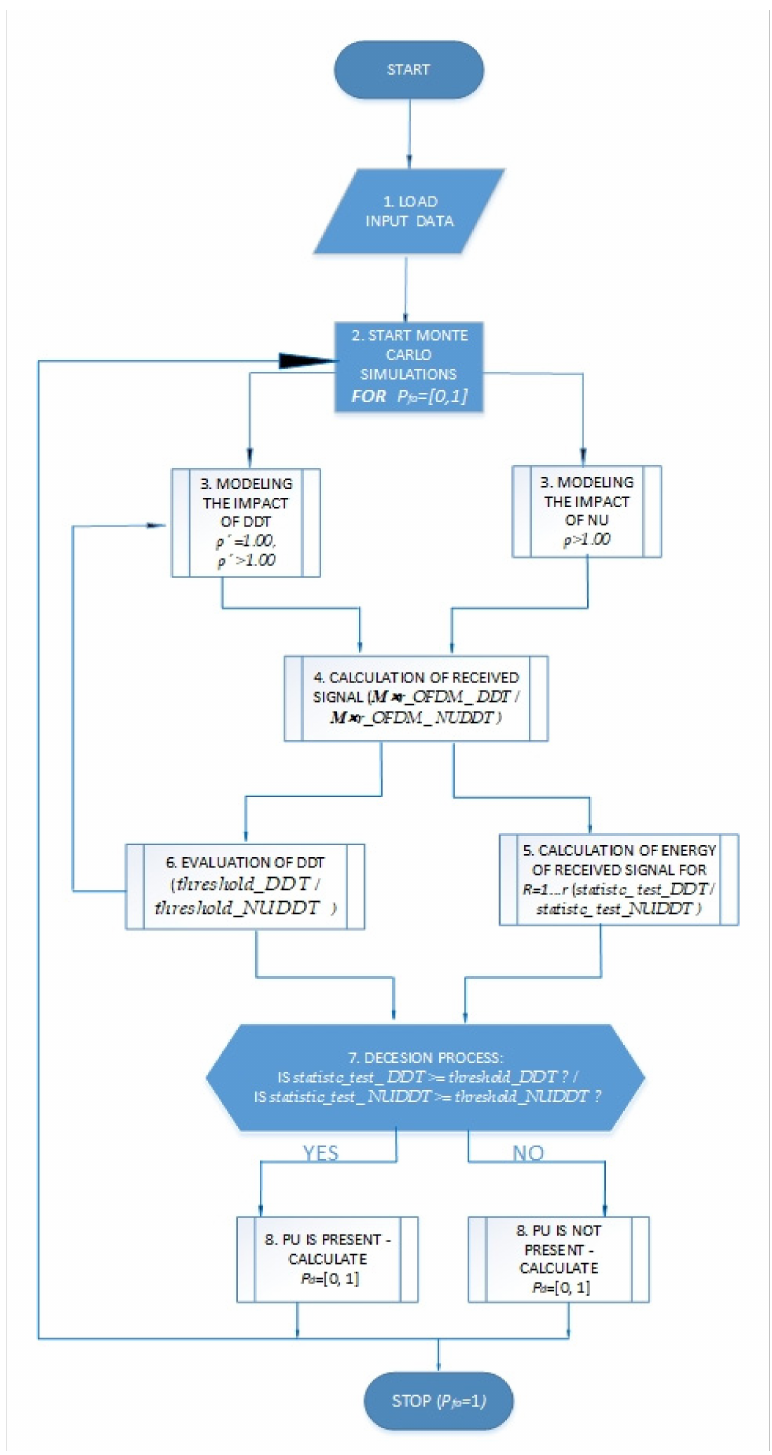
Figure 3. Flowchart of Algorithm